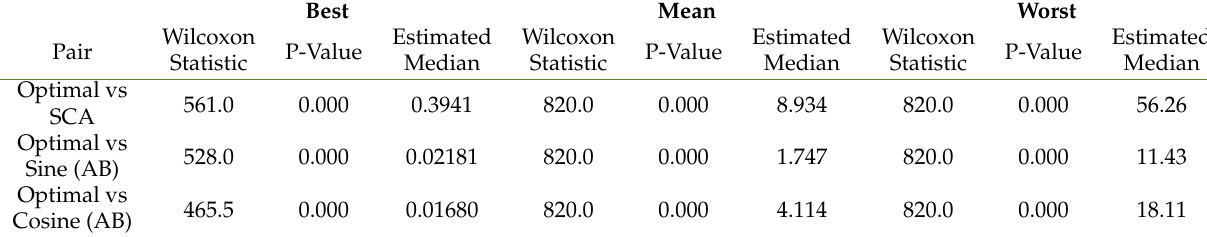
Table 12. Wilcoxon Signed Rank Rest (a = 1, 2 for SCA)